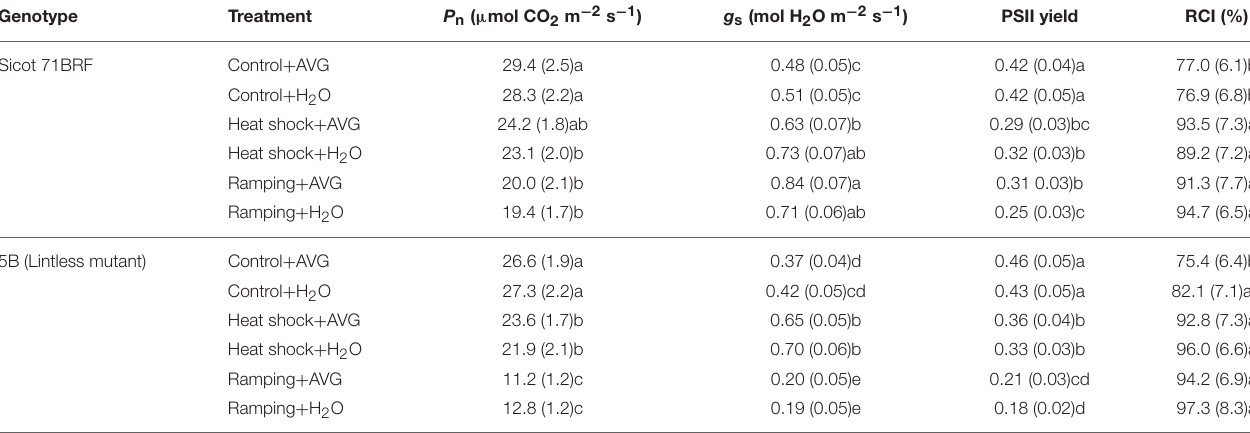
TABLE 1 | Changes in various physiological components of different cotton genotypes in response to heat shock (45 ◦ C), ramping heat (45 ◦ C), and aminoethoxyvinylglycine (AVG) application in Experiment 1. Genotype